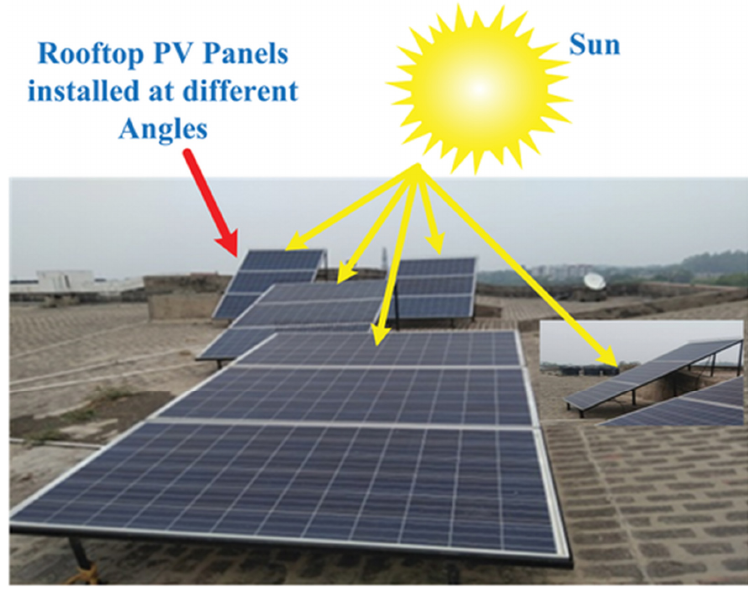
Figure 14. Solar panels installed at different tilt angles [102].